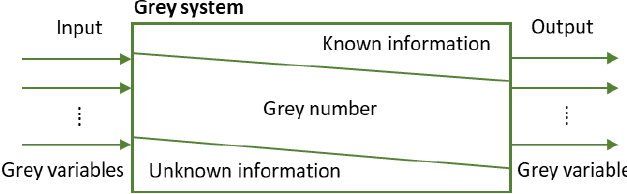
Figure 3. The concept of grey theory [67].